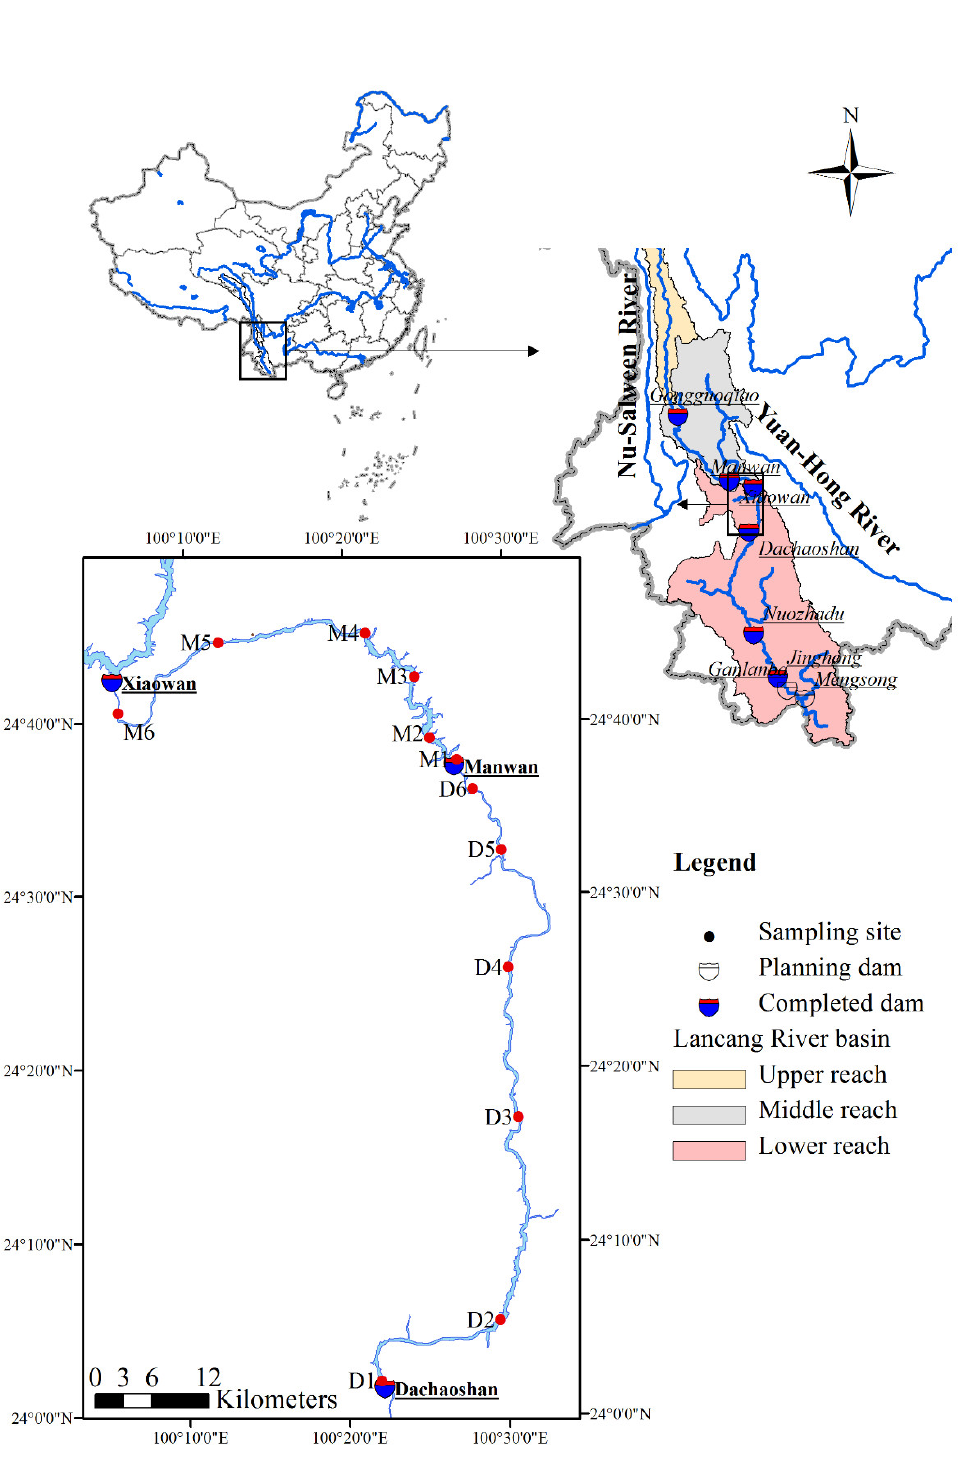
Figure 1. Location of surface sediment sampling sites in Manwan (M) and Dachaoshan (D) cascad- ing dams.